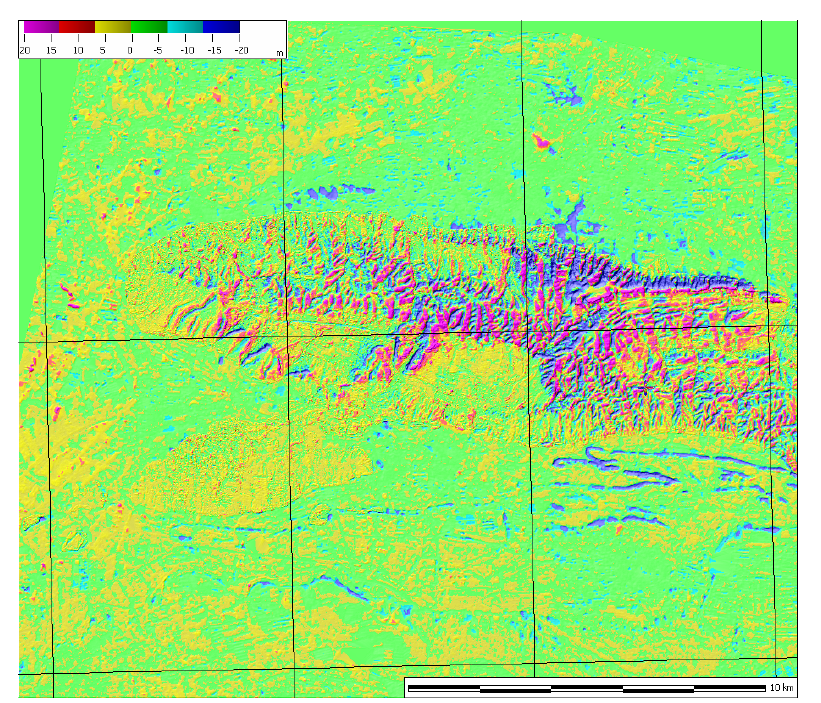
Figure 1. Residuals for the 10 m resolution DSM generated over Mausanne les Alpilles